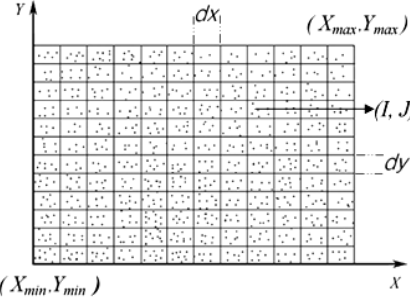
Figure 8. Projection of normalized point cloud data onto blocks.